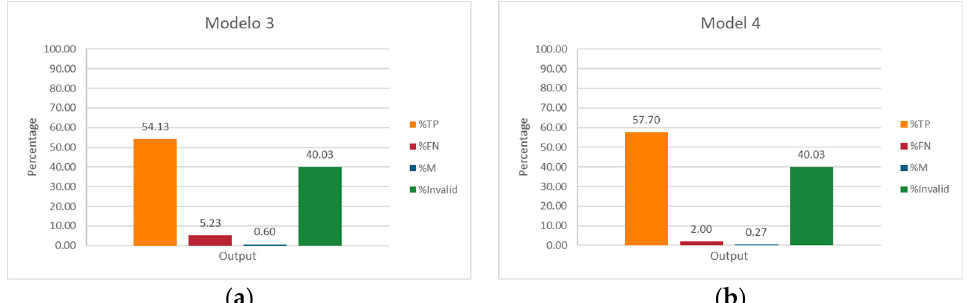
Figure 4. Percentage of total True Positives (%TP), False Negatives (%FN), Misclassifications (%M) and ‘Invalid’ output, for ( a ) Model 3, using single scan data, and ( b ) Model 4, using triple scan data.